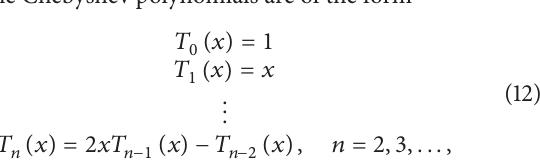
The Chebyshev polynomials are of the form